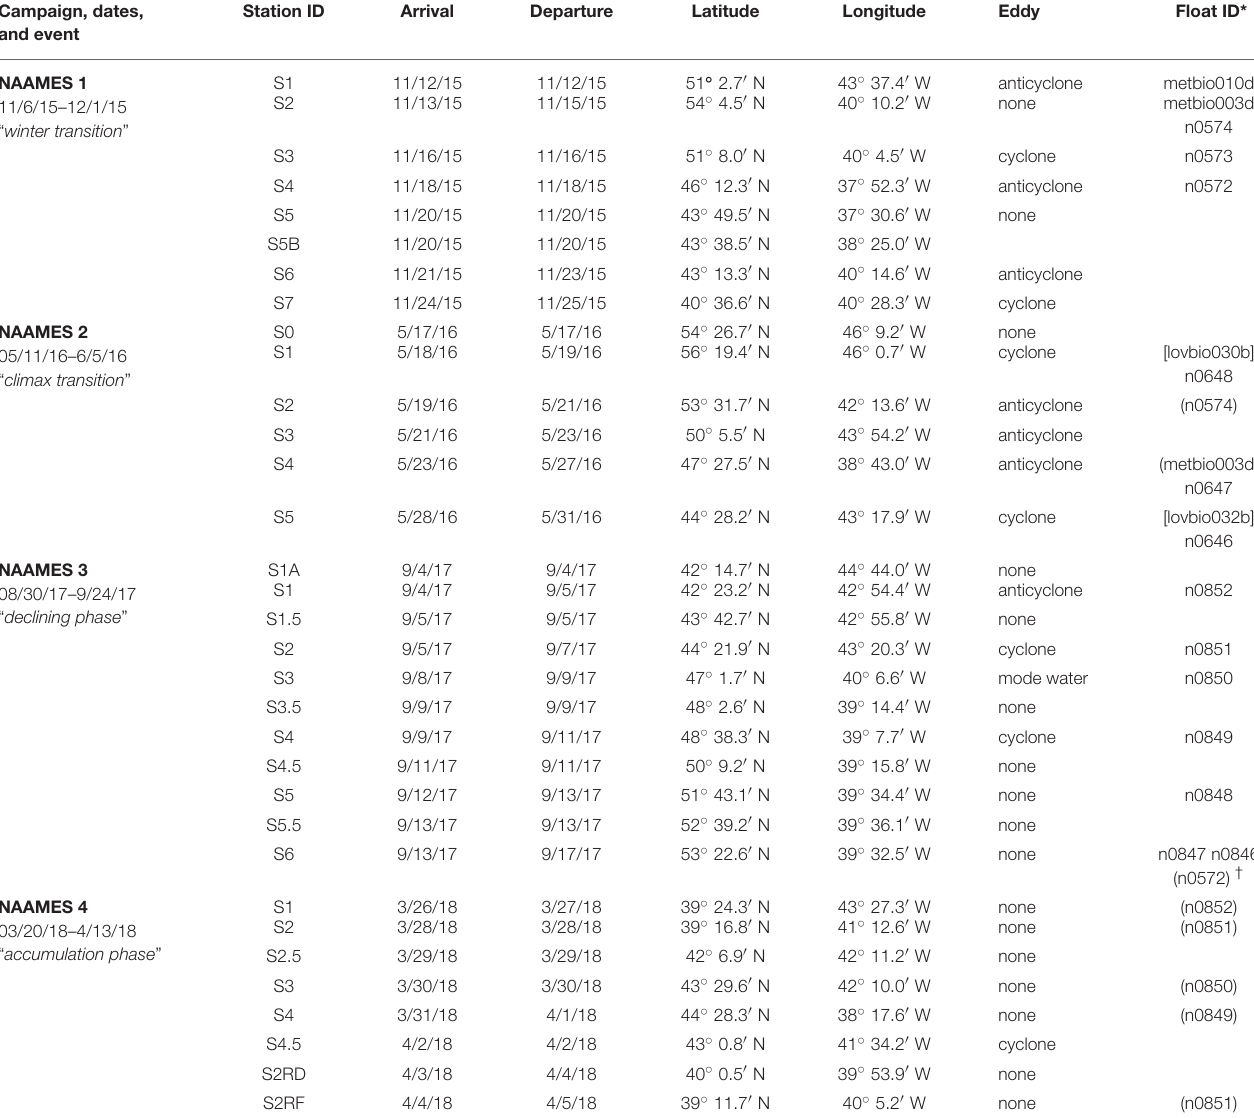
TABLE 1 | Summary of NAAMES ship stations. Campaign, dates, and